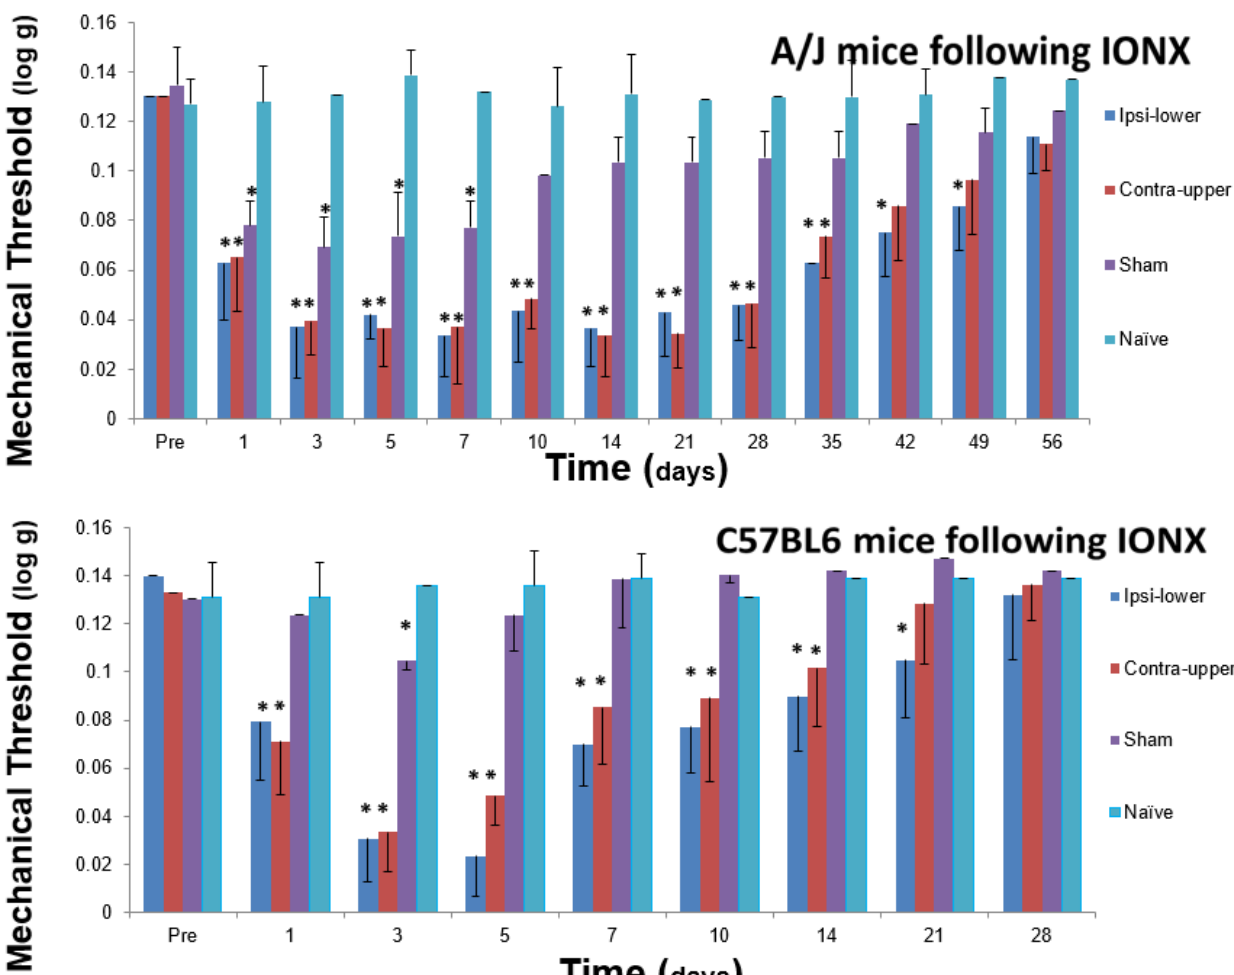
Figure 5. Infraorbital nerve injury in the mouse induces facial mechanical hypersensitivity that is genetically dependent. A/J and C57BL/6J male mice aged 8–12 weeks were maintained under similar environmental conditions, and were tested with von Frey monofilaments for facial mechanical sensitivity before and after unilateral transection (IONX) of the medial branch of the infraorbital nerve (that supplies medial aspect of upper lip, vibrissal pad and anterior teeth) or sham operation; naïve mice were also tested ( n = 11/group). Baseline values of facial mechanical sensitivity as reflected in head withdrawal threshold were comparable in A/J and C57BL/6J mice, and following IONX both strains showed evidence of ETSS as reflected in hypersensitivity in the ipsilateral lower lip and contralateral upper lip when compared with the sensitivity in naïve and sham animals. However, the time course of the IONX-induced facial hypersensitivity was significantly different (2 way ANOVA, p < 0.05) between the two strains of mice: hypersensitivity in both A/J and C57BL/6J mice started around post-operative day 1, but in the A/J mice reached its peak throughout post-operative days 3–21 and lasted up to day 49, whereas in the C57BL/6J mice, hypersensitivity had a significantly shorter peak duration. Moreover, hypersensitivity lasted up to days 35 (contralateral upper lip) and 49 (ipsilateral lower lip) in A/J mice but only to days 14 and 21, respectively, in C57BL/6J mice. Sham animals (compared to naïve animals) showed a brief hypersensitivity that also was significantly longer in the A/J mice. * p < 0.05. Based on data from Varathan et al. [121] and Cherkas et al. [168].